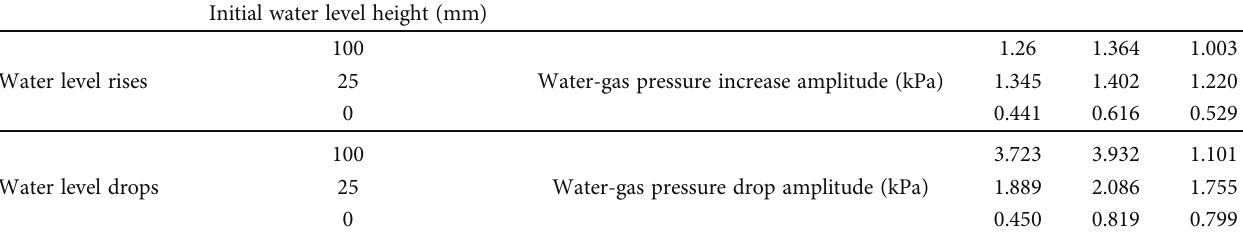
Figure 5: Variation of water-gas pressure with time. Table 3: The amplitude of increase and decrease of water-gas pressure during the next water level rise and fall with di ff erent initial water level